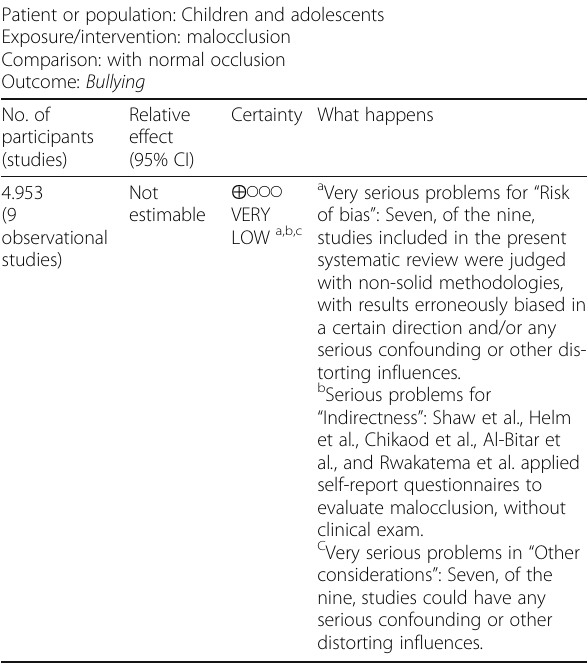
Table 5 Evidence profile: relationship between malocclusion and bullying Patient or population: Children and adolescents Exposure/intervention: malocclusion Comparison: with normal occlusion Outcome: